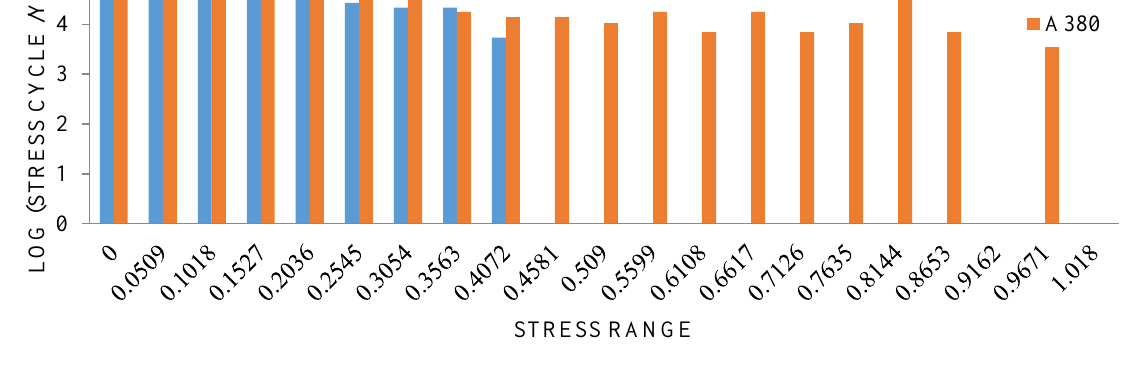
Fig. 12. Histogram for Stress ranges vs. Frequency (cycles/year) for A-310 and A-380 (h=20cm,E=30000MPa).